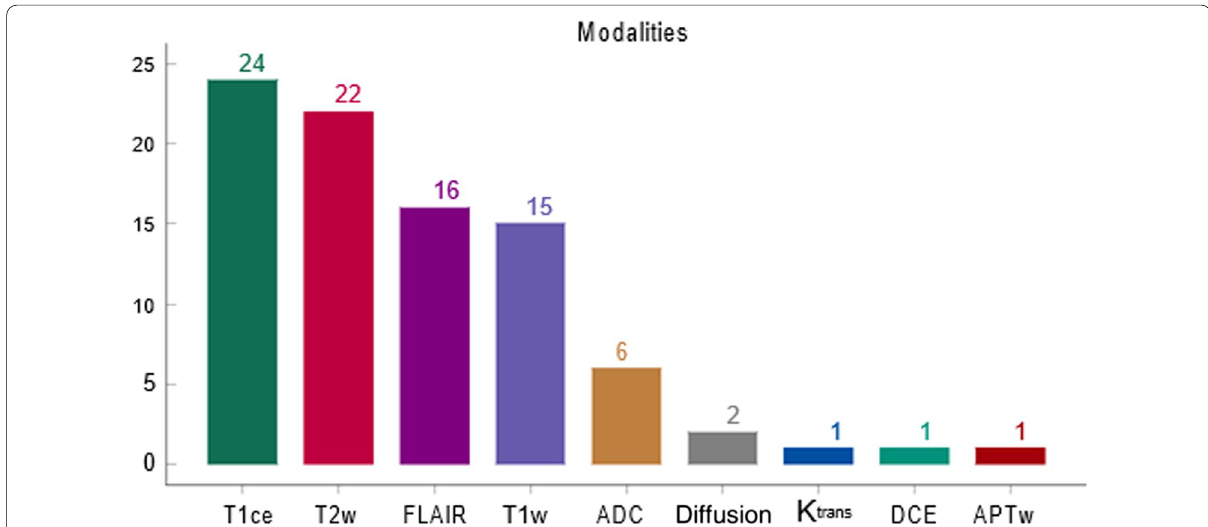
Fig. 1 The MRI sequences were used in the examined studies. The brain anatomical region included the most studies which justify the reason that T1 contrast-enhanced (T1ce), T2-weighted (T2w), fluid-attenuated inversion recovery (FLAIR) and T1-weighted (T1w) modalities prevail in the above bar chart. Apparent diffusion coefficient, diffusion (ADC), K trans , and dynamic contrast-enhanced (DCE) modalities were examined in the prostate anatomical region. The remained anatomical regions (i.e., pancreas, breast, liver) included as well the first four depicted modalities. Lastly, one study which concerned the brain region examined amide proton transfer weighted (APTw)